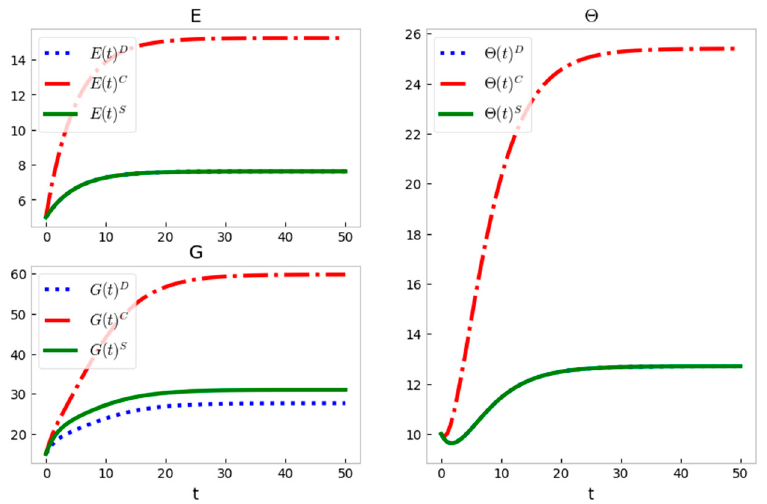
Figure 4. Trajectory of eco-quality, consumer ecological perception, and goodwill.